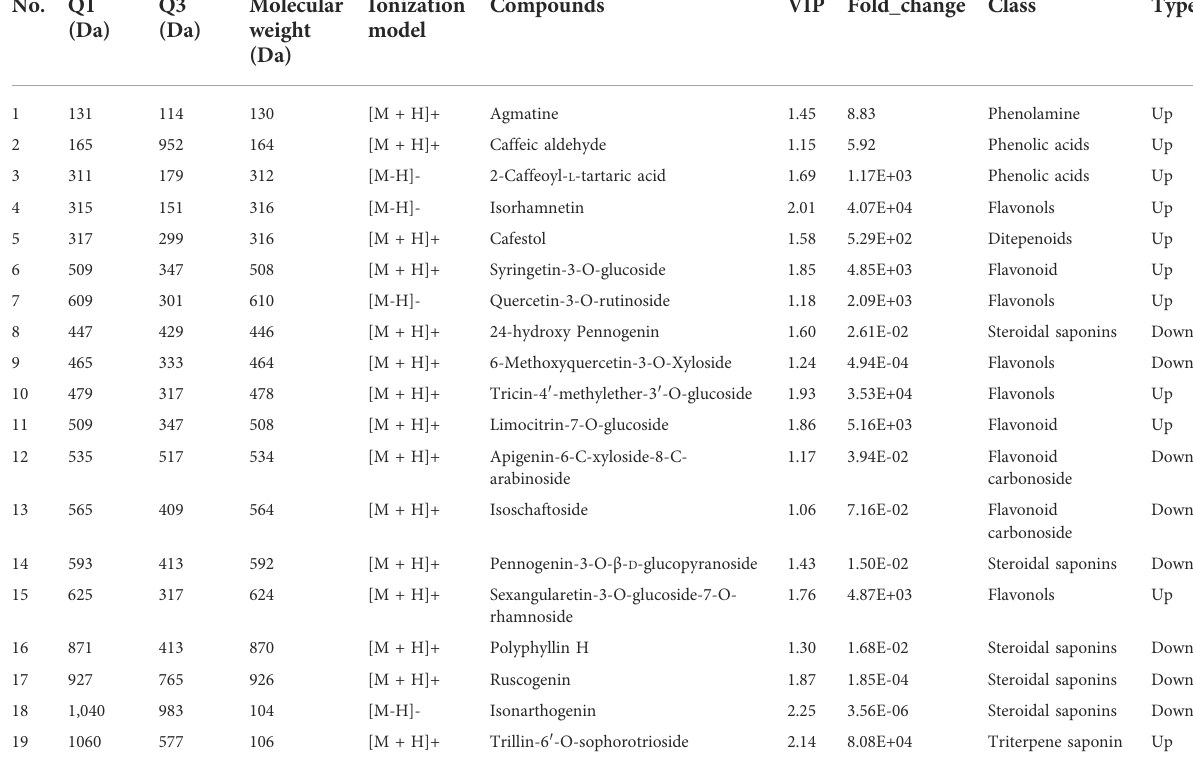
TABLE 1 Overlapping differential metabolites in all the comparison